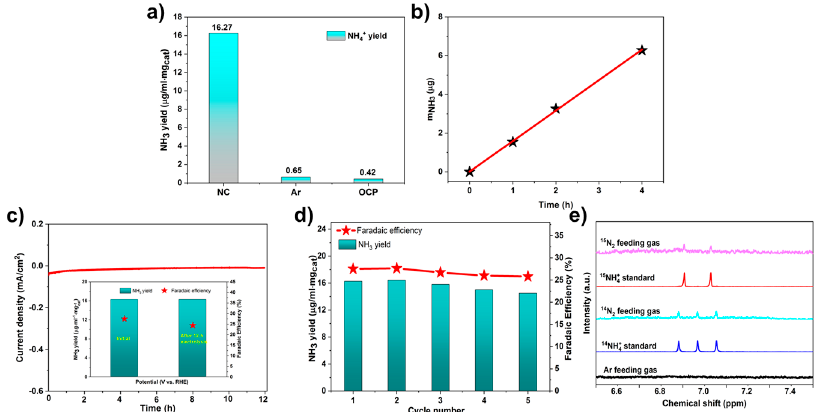
Figure 2. ( a ) The NH 3 production for NC under various conditions: at − 0.35 V in N 2 , open circuit in N 2 , and − 0.35 V in Ar for 2 h. ( b ) The curve of NH 3 production versus reaction time at − 0.35 V. ( c ) The time-dependent current density curve for NC at − 0.35 V in N 2 for 12 h (inset, NH 3 yield rates and FEs for NC before and after 12 h at − 0.35 V). ( d ) The NH 3 yield rates and FEs for NC at − 0.35 V over 5 cycles. ( e ) 1H NMR spectra of the electrolytes after NRR electrolysis on NC for 2 h using Ar gas, 14 N 2 gas, 15 N 2 gas as the feeding gas.